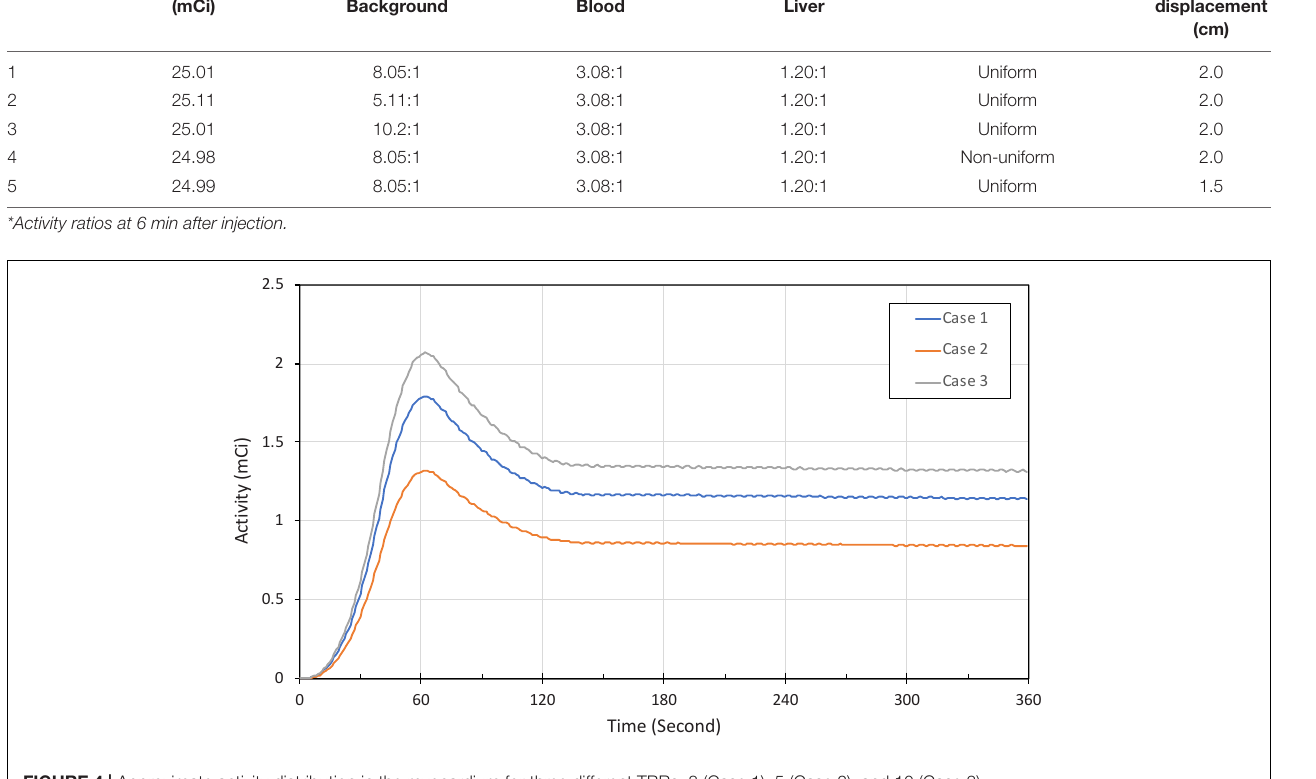
FIGURE 4 | Approximate activity distribution in the myocardium for three different TBRs: 8 (Case 1), 5 (Case 2), and 10 (Case 3).